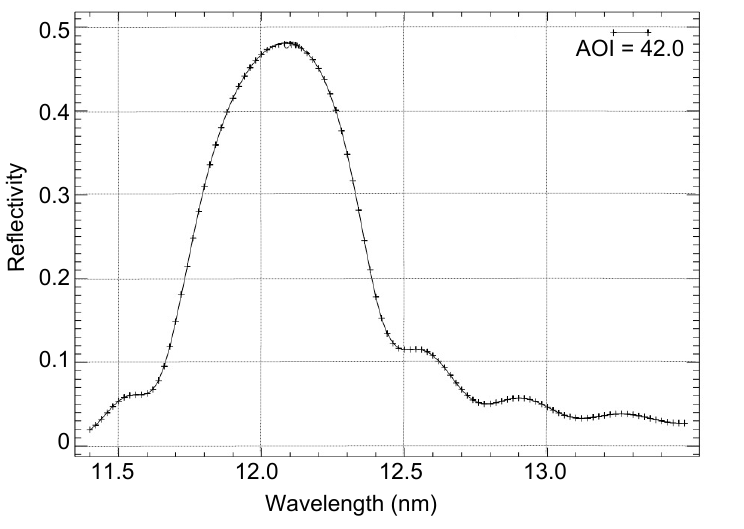
Figure 3. Reflectivity versus wavelength of the polarizer multilayer mirrors at the Brewster incident angle (42 ◦